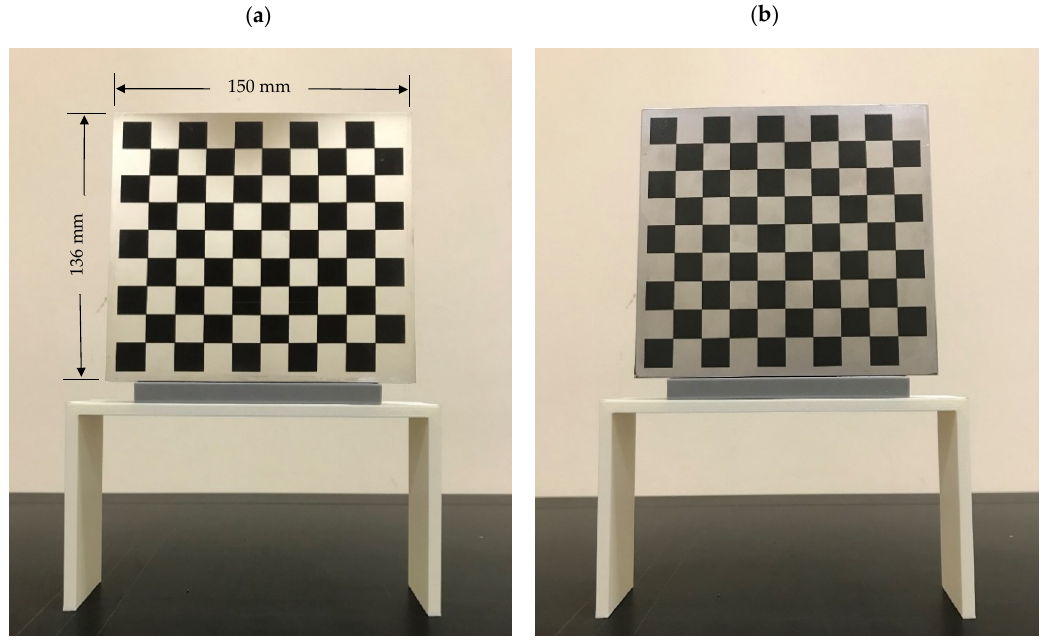
Figure 3. Optical images of ( a ) the laser-engraved and ( b ) the UV-printed checkerboard patterns. Table 2. Physical and thermal properties of the SS304 calibration